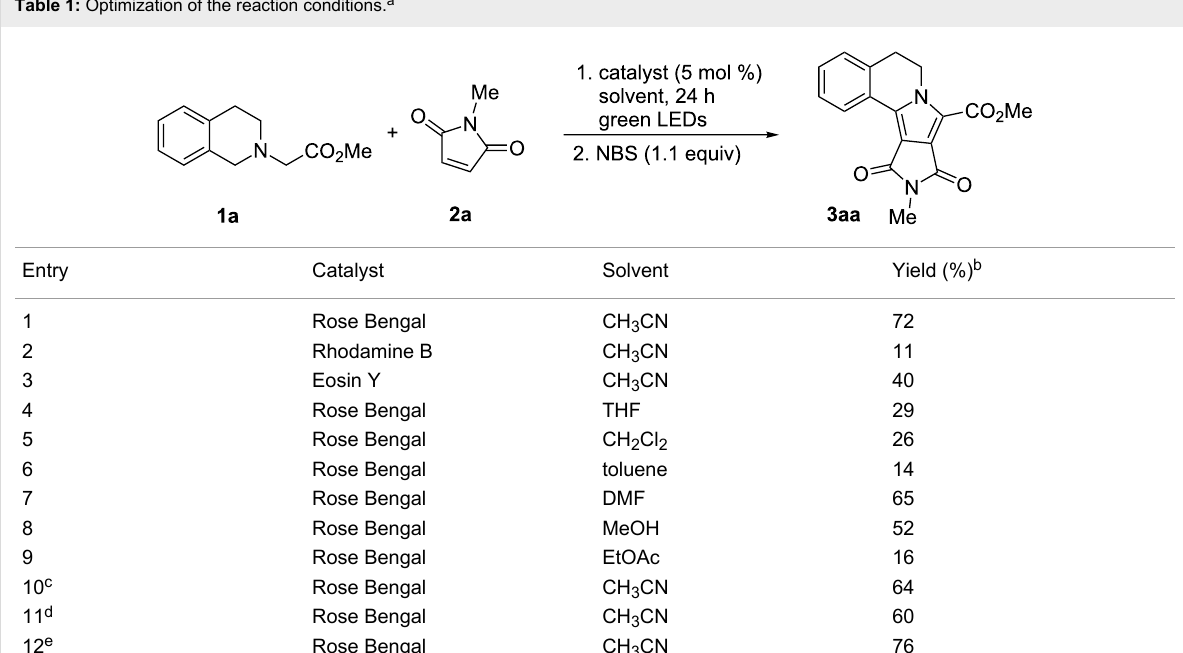
Table 1: Optimization of the reaction conditions. a